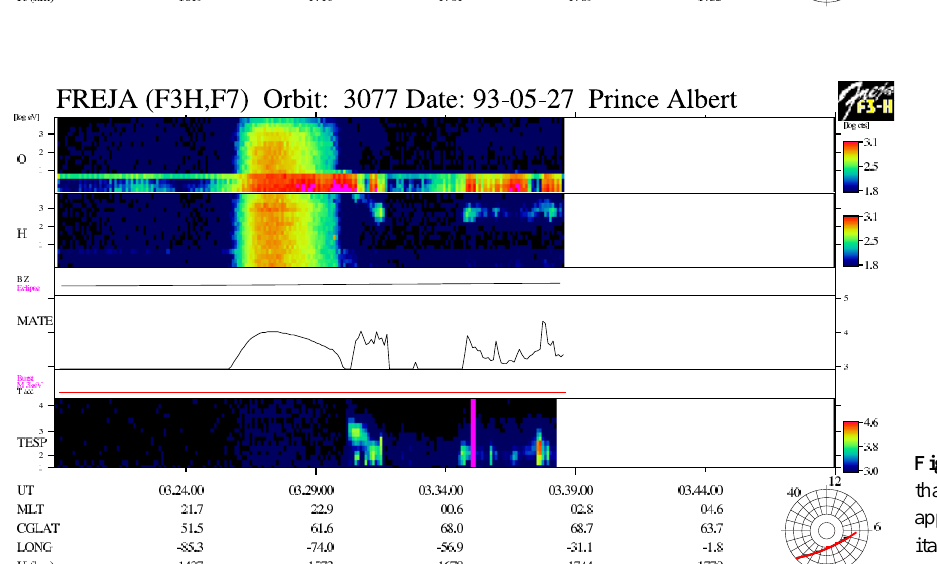
Fig. 11. A full-pass CSP showing the occurrence of precipitated ions in the keV energy range in most of the pas- sage through the auroral regions.